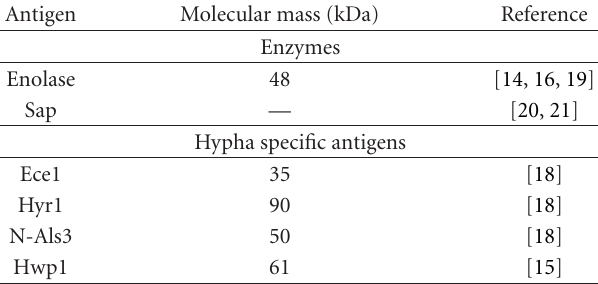
Table 1: Candida recombinant antigens tested for serodiagnosis of invasive